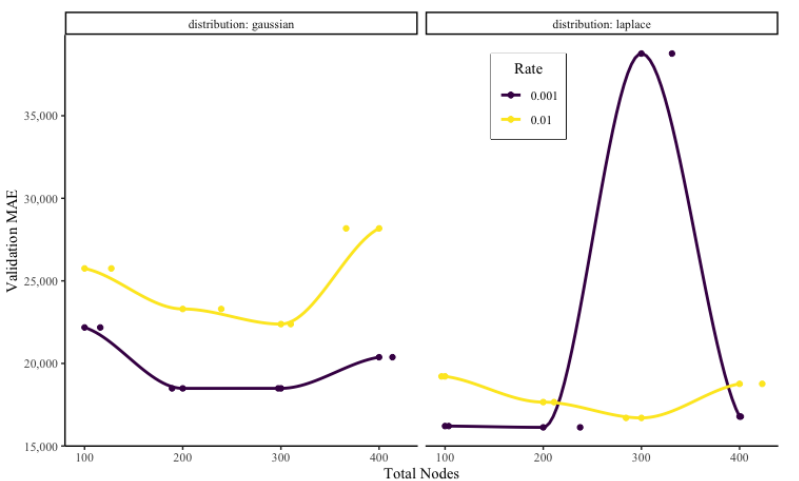
Figure 7. Visualization of the results from tuning deep learning models to predict severity on the BI data. Validation MAE is shown as a function of the total nodes in the neural network, with each pane showing a different distributional assumption of the network and each line representing a different learning